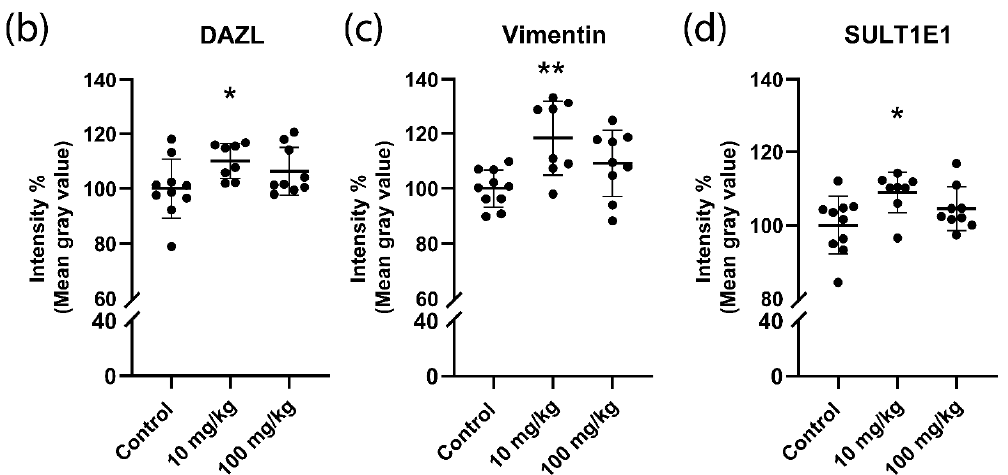
Figure 6. Persistent effects of five weeks oral DBP exposure on testicular cell markers in adult mice. Representative images of testis cross-sections from DBP-treated mice or control ( a ). DAZL (green), vimentin (purple) and SULT1E1 (red) by immunofluorescence in cryosections from mouse testis collected one week after the last DBP administration. The nuclear marker DAPI is shown in blue. Fluorescence intensity quantification of DAZL, vimentin and SULT1E1 is shown as a percentage of control ( b – d ). Data are represented as mean ± SD ( n = 8–11 animals per group). Statistically significant differences from control are indicated as follows: * p < 0.05 and ** p < 0.01 (Kruskal–Wallis test followed by Dunn’s test). Scale bar: 50 µm. The Western blot analysis of these cell markers showed similar results as the immu- nofluorescence analysis of the cryosections, with some slight differences. The results for